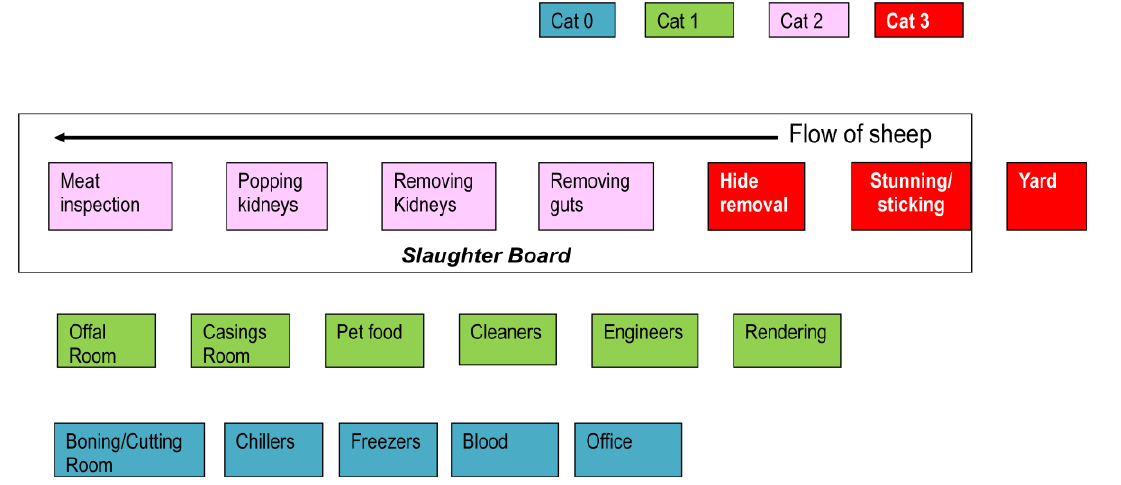
Figure 1. Schematic description of the various workplaces of workers in sheep abattoirs by category (colours) used in multivariable